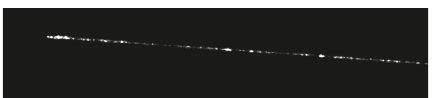
Figure 5: Speckle noise in image of a laser line on metallic